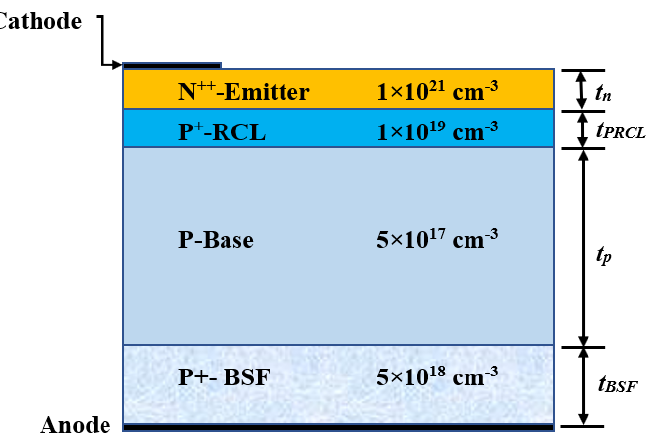
Figure 2. Representative figure of the proposed self-protected thin-film Si cell including a reverse conducting